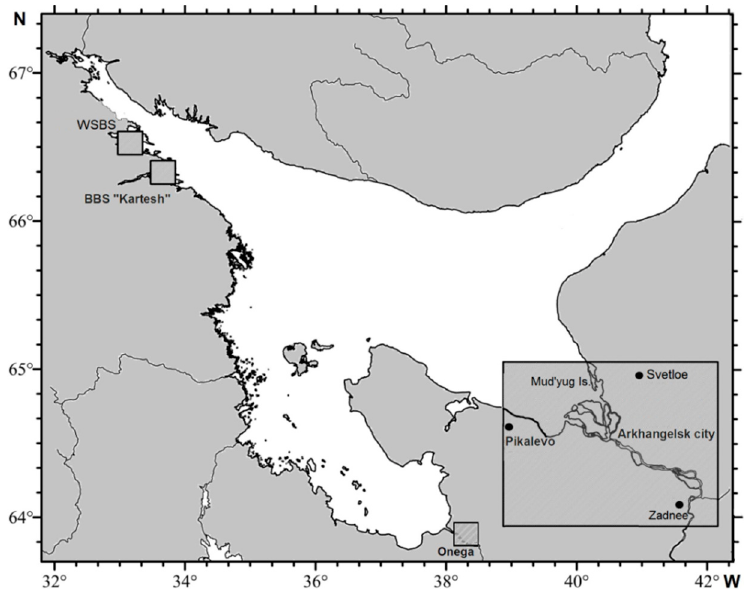
Figure 2. The main areas of snow and ice cover sampling in the White Sea: WSBS—vicinity of the Pertsov White Sea Biological Station of Lomonosov Moscow State University, Rugozerskaya Bay (stations 1 and 2 are inside this box); BBS “Kartesh”—vicinity of the White Sea Biological Station of Zoological Institute RAS near cape Kartesh; Onega—mouth of Onega river; area of mouth of Severnaya Dvina river mouth near Arkhangelsk.